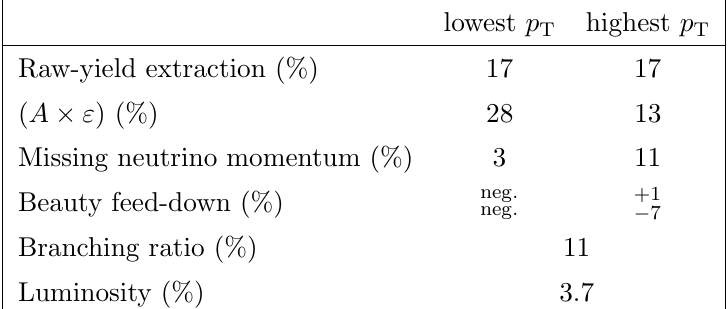
Table 4 . Summary of relative systematic uncertainties for the (cid:3) + The uncertainties smaller than 1% are considered negligible (\neg." in the